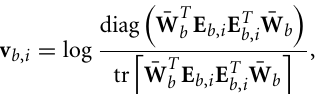
Frontiers in Neuroscience |